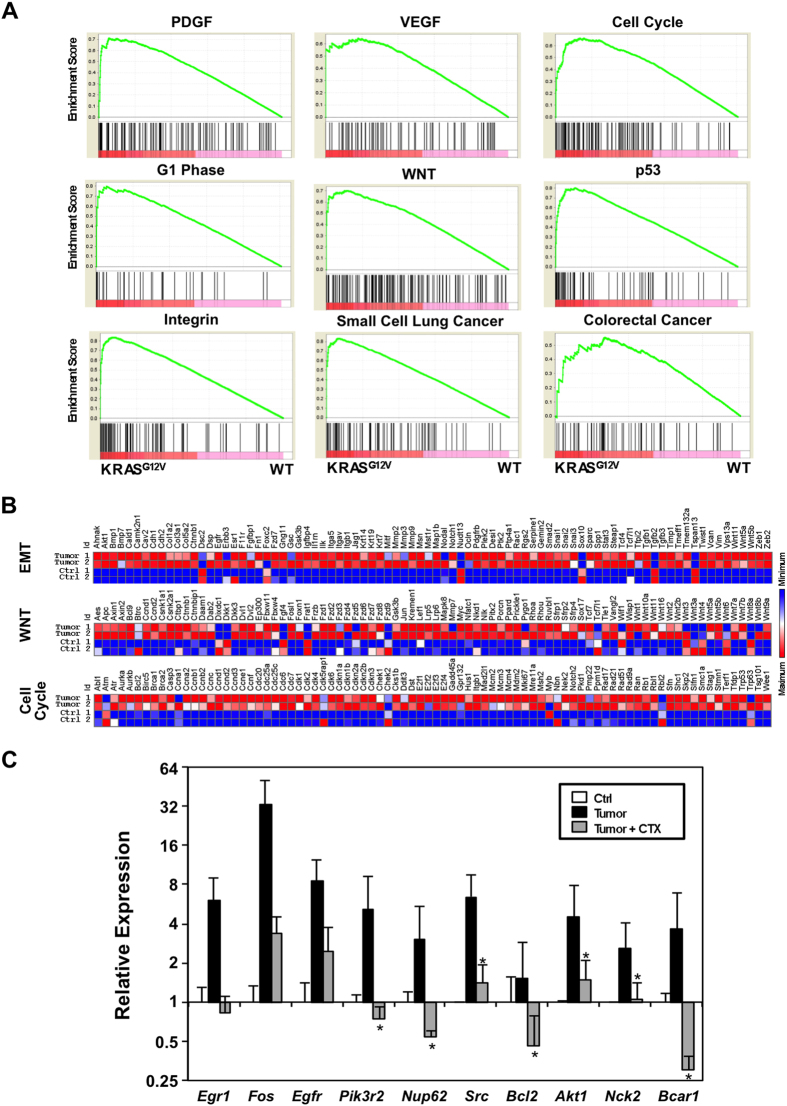
KRASG12V activates multiple signaling pathways in the tumors.(A) Gene Set Enrichment Analysis (GESA) of enriched pathways activated by KRASG12V. Messenger RNA was extracted from tumor samples and normal gland samples for RNA-seq. GESA showed that upregulated genes were enriched in the indicated pathways. p < 0.01 and an FDR < 25%. (B) PCR array analyses of mRNA showed that genes in EMT, WNT, and Cell Cycle pathways were upregulated in the tumors compared to normal gland tissue, with p < 0.001. (C) The effect of EGFR inhibitor cetuximab (CTX) on the signaling pathways activated by KRASG12V. Quantitative RT-PCR showed that multiple components of EGFR pathway were activated in tumors, and these activated components were effectively inhibited by cetuximab. *p < 0.05.